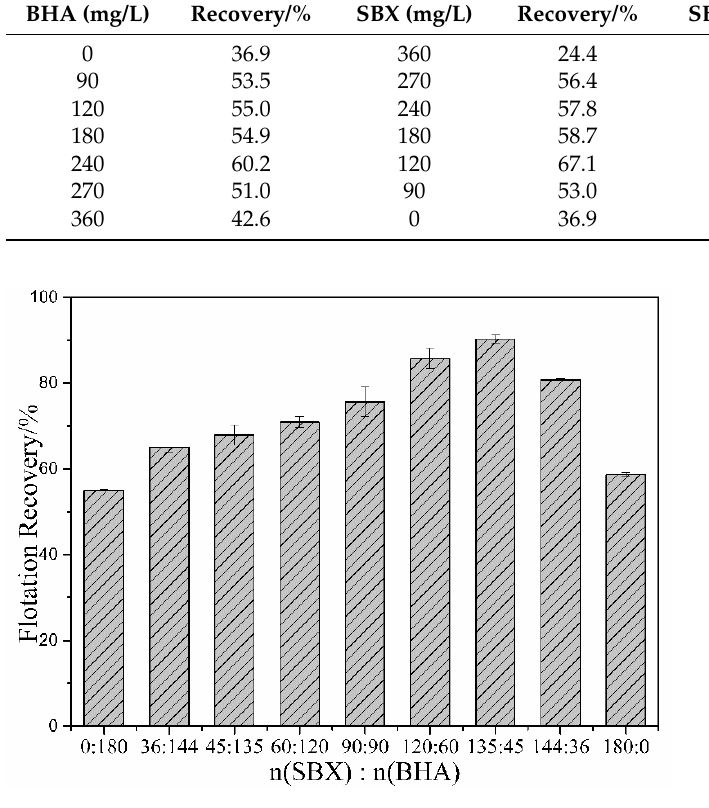
Figure 4. Effect of the molar ratio of SBX and BHA on flotation recovery. The dosage of Na 2 S is 220 mg/L, pH = 9.5, and the total dosage of SBX with BHA is 180 mg/L. Table 1. The flotation recovery of malachite by using SBX, BHA, and their mixture (the total dos- age of SBX + BHA is 180